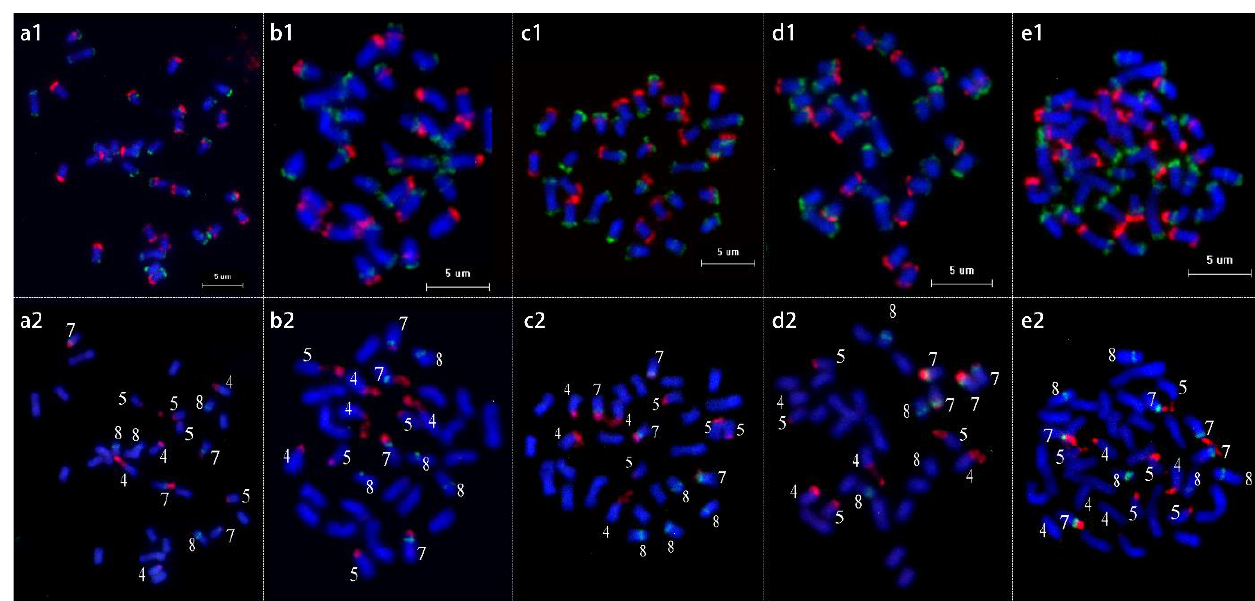
Figure 6. FISH of 5S rDNA and 45S rDNA accurately identified five Chinese cherries. ( a1 – e1 ) First round of FISH using two sets of oligo sublibrary probes on metaphase chromosomes for chromosome identification. P. pseudocerasus _HC ( a1 ), P. pseudocerasus _BZ ( b1 ), P. pseudocerasus _HF ( c1 ), P. pseudocerasus _PJHH ( d1 ), and P. pseudocerasus _FM2 ( e1 ). ( a2 – e2 ) The same cells in ( a1 – e1 ) reprobed with using 5S rDNA (green) and 45S rDNA (red) probes.